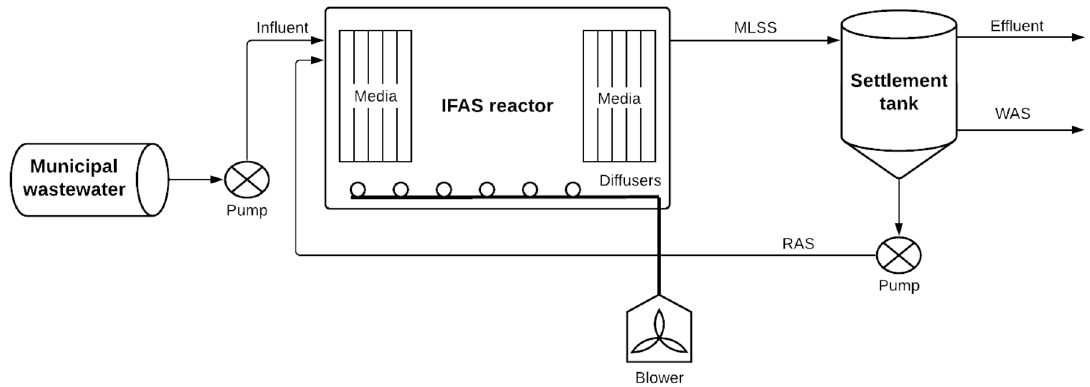
Figure 1. Modelled system